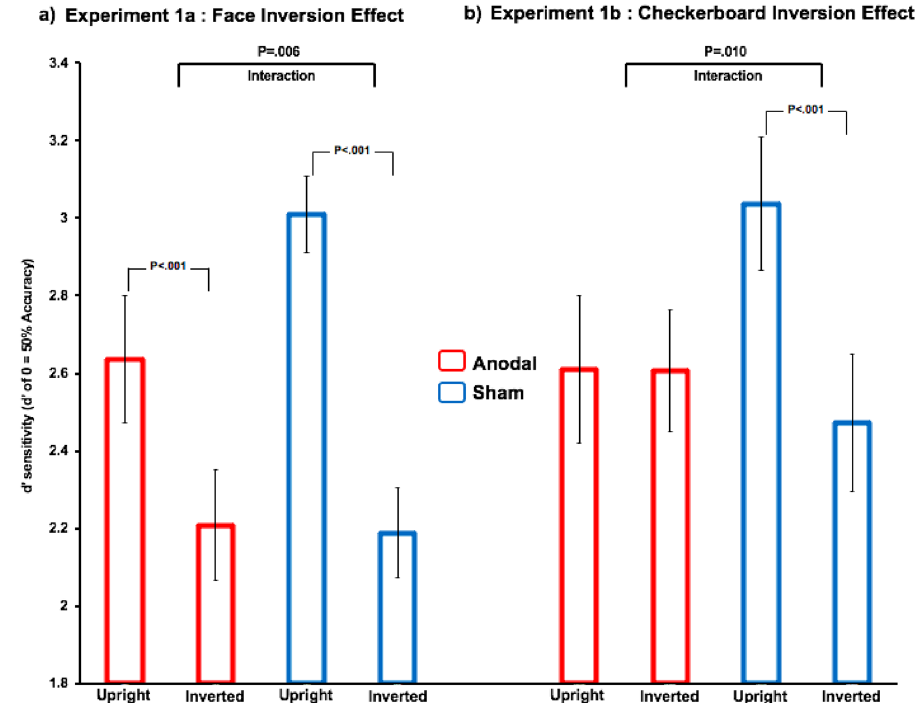
Figure 3. Panel ( a ) reports the results from Experiment 1a. Panel ( b ) reports the results from Experiment 1b. In both panels, the x -axis shows the stimulus conditions, the y -axis shows d’. Error bars represent s.e.m. In both experiments, performance against chance in both the sham and anodal groups was significantly above chance (for all conditions we found p < .001 for this